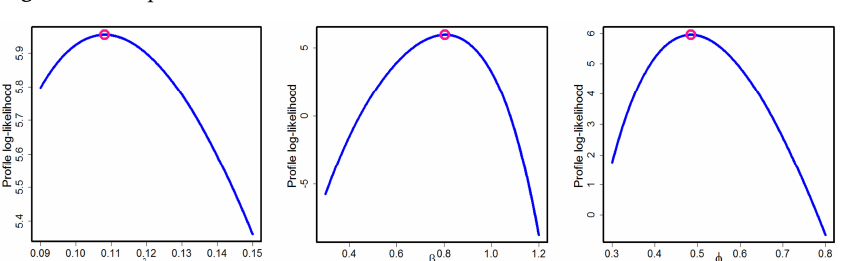
Figure 14. P-P plot for Data Sets I and II. Fig. 14: P-P plot for Data Sets I and II.